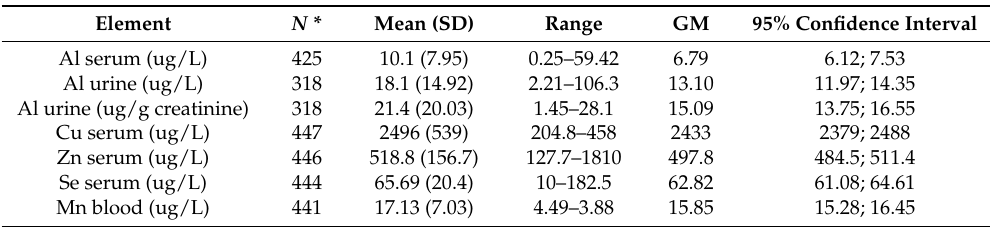
Table 3. Concentration of Al in serum and urine, Cu, Zn, and Se in serum and Mn in whole blood in South African delivering